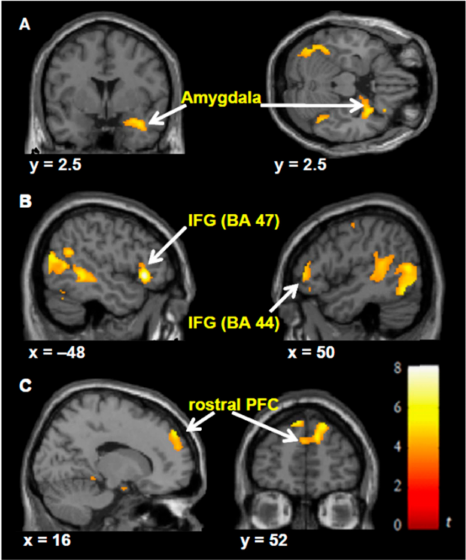
Figure 5. Significant hemodynamic activity during observation of avatar in pain compared with not in pain. Observing the avatar in pain compared with no pain-evoked differences in brain activation in the right amygdala and periamygdala areas ( A ), Inferior frontal gyrus (IFG)-Brodmann’s area (BA 47, BA44) ( B ), and bilateral rostral prefrontal cortex (rPFC) ( C ). Images are superimposed on the coronal and sagittal sections of the single subject structural Montreal Neurological Institute (MNI), template. All rights reserved, with permission from Frontiers. Reference